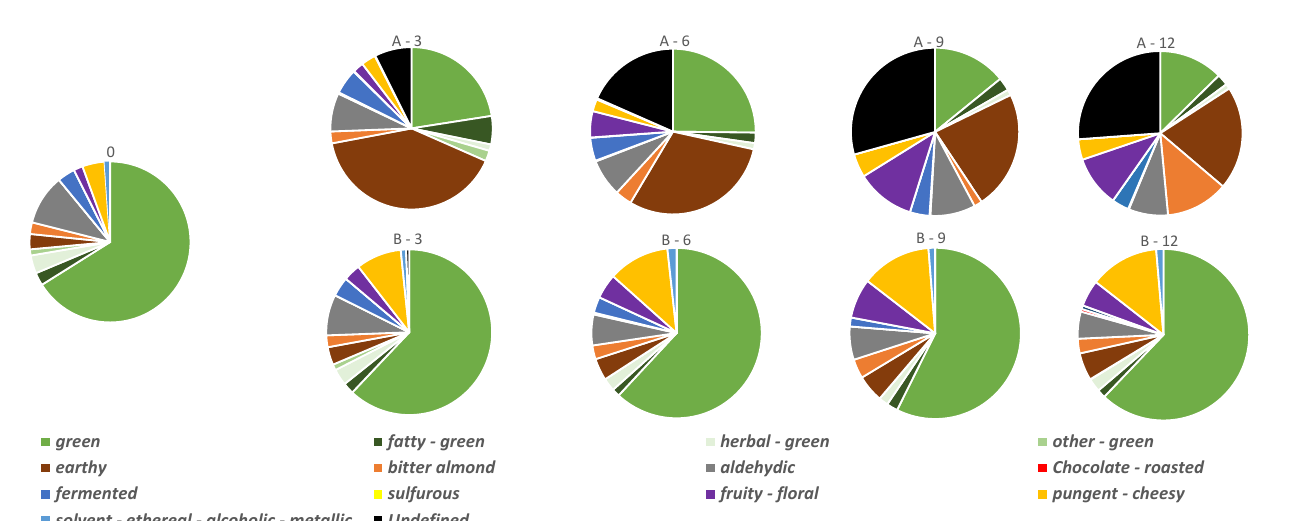
Figure 3. Profile in ratios of volatile compounds sorted by sensory descriptors during the two ageing conditions ( n = 3). A given descriptor was represented as the ratio of the percentage of the cumulative amount of the volatile compounds responsible for the descriptor to the total amount of all volatile compounds. Treatment A: 20 °C—Light, Treatment B: 30 °C—Dark.